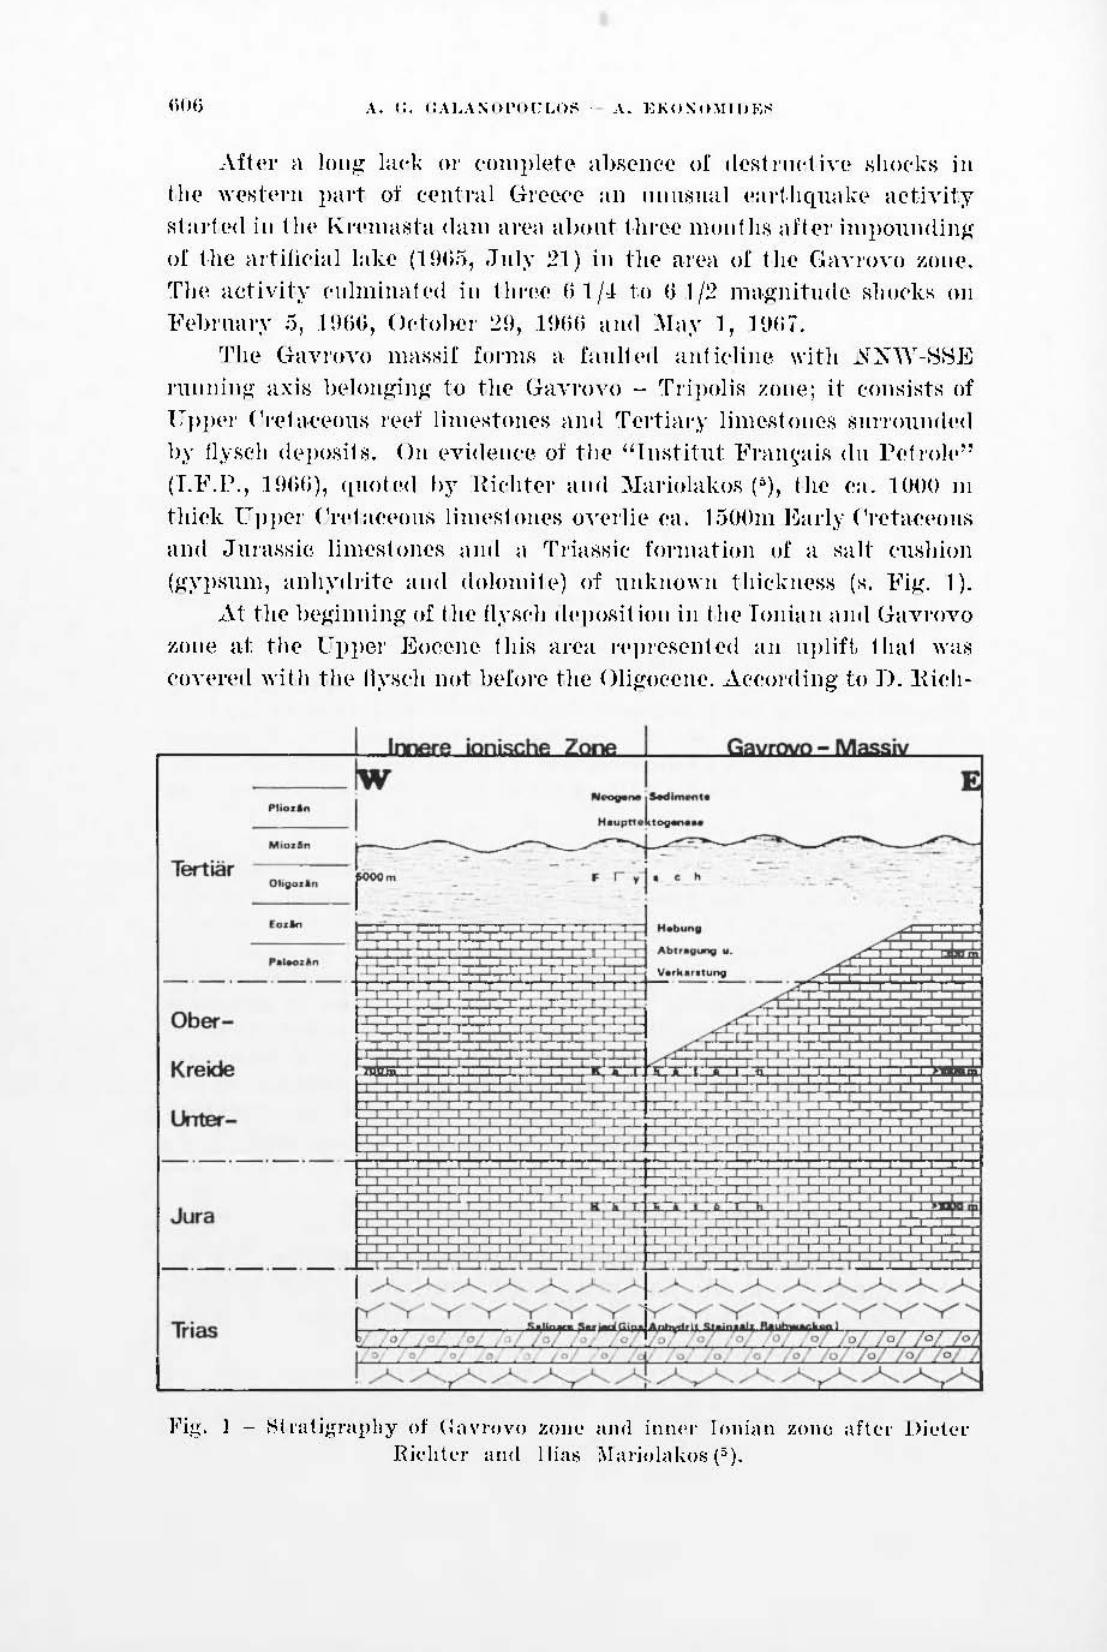
Fig, l - t4!mtigraphy of (~a\'l'ovo ZOlle aml illlwr !oniall zone afte!'